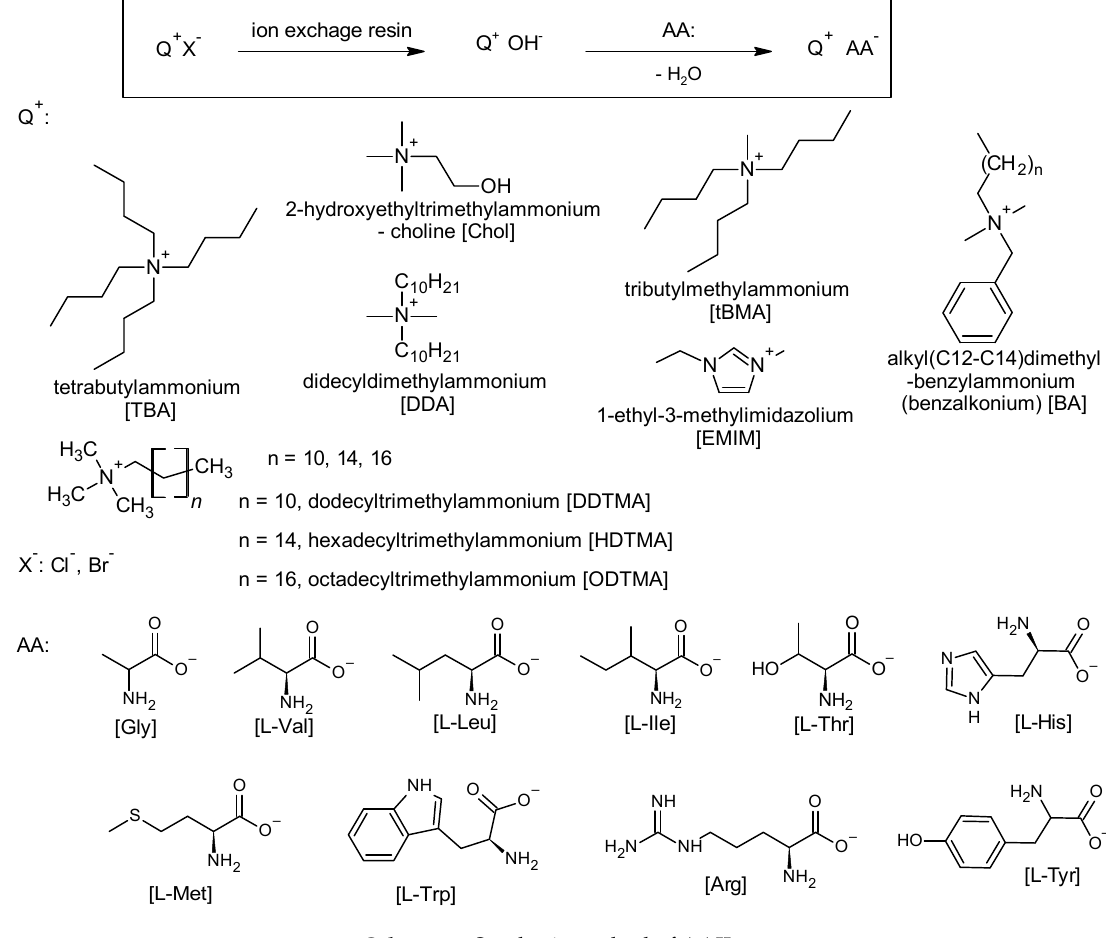
Table 1. 1 H-NMR and 13 C-NMR chemical shifts (relative to TMS) of α -positions (H-1 ′ , C-1 ′ ) and C=O of compounds studied in DMSO-d 6